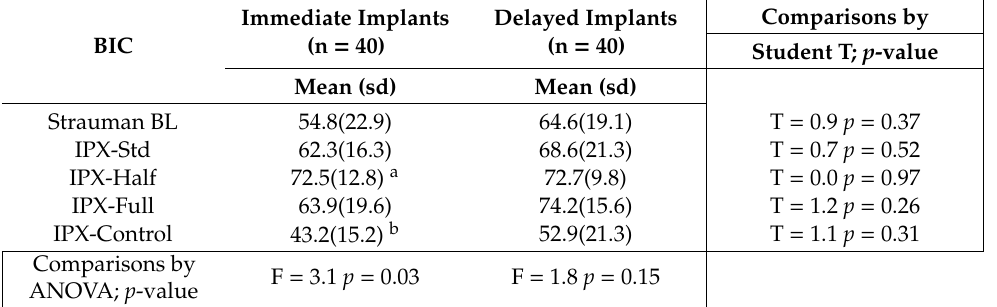
Table 6. Comparison of the BIC (bone-to-implant-contact) between delayed and immediate implants in both the buccal and lingual sides (mm) among the implant subgroups. The letters (a,b) indicate the groups that are statistically di ff erent after post hoc Bonferroni correction.